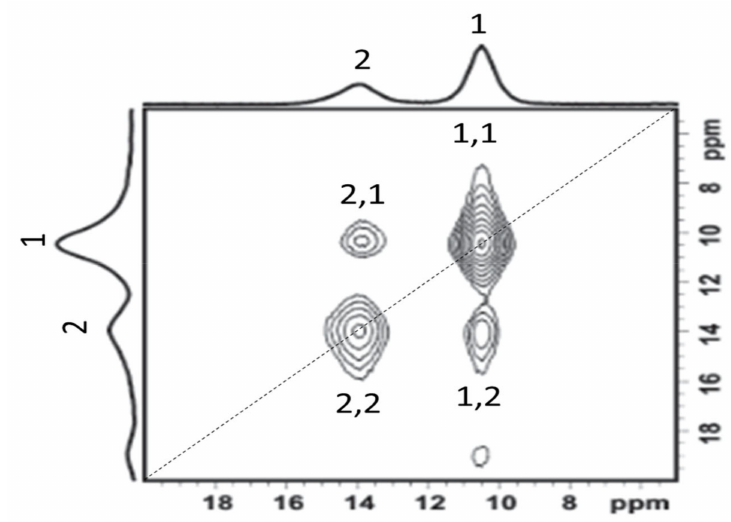
Figure 15. Sample EXSY spectrum. Diagonal peaks (1,1 and 2,2 along the dotted line) represent the original position of each spin and have the same frequency coordinates on both axes. Cross peaks (1,2 and 2,1) represent exchanged spins and have different frequency coordinates on each